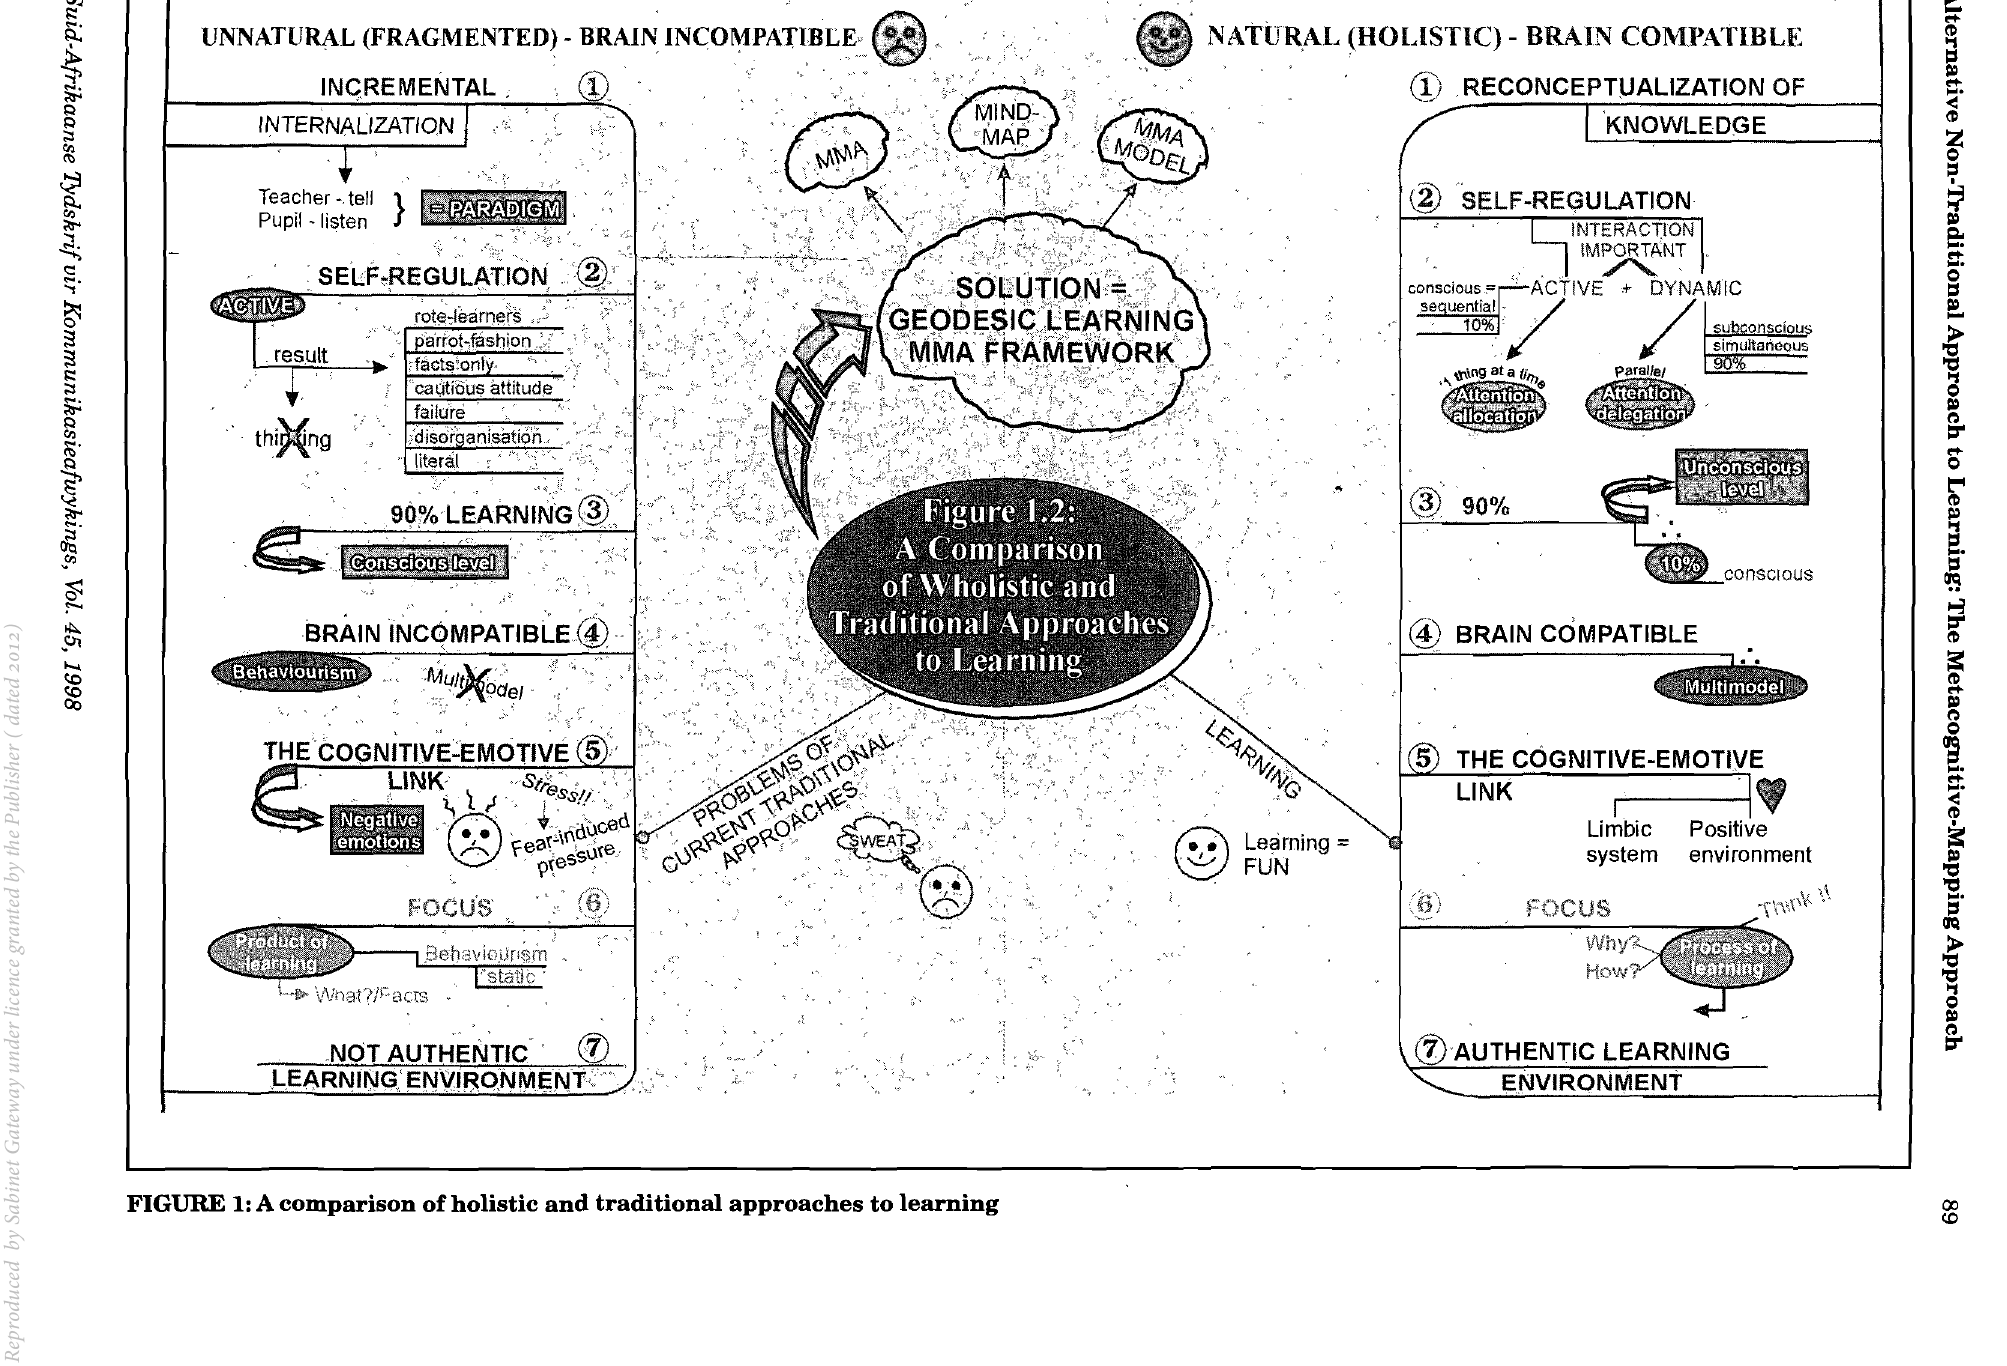
FIGURE 1: A comparison of holistic and traditional approaches to